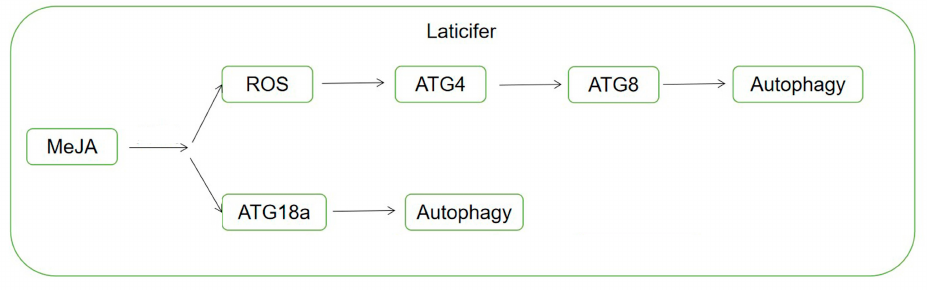
Figure 10. The hypothetical model of the mechanism of MeJA-mediated autophagy in E. kansui laticifer.